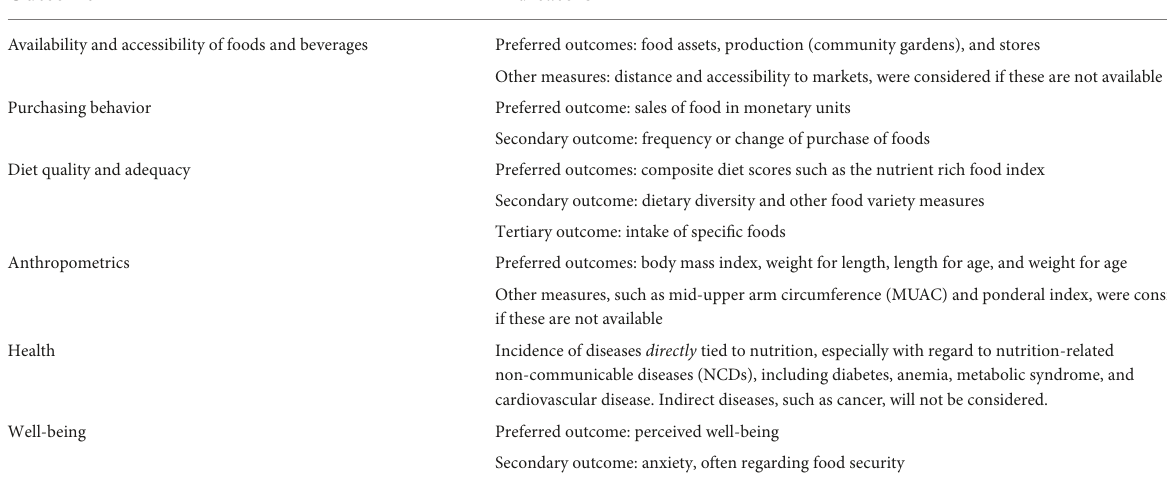
TABLE 2 Included outcomes and indicators extracted for evidence synthesis. Outcome